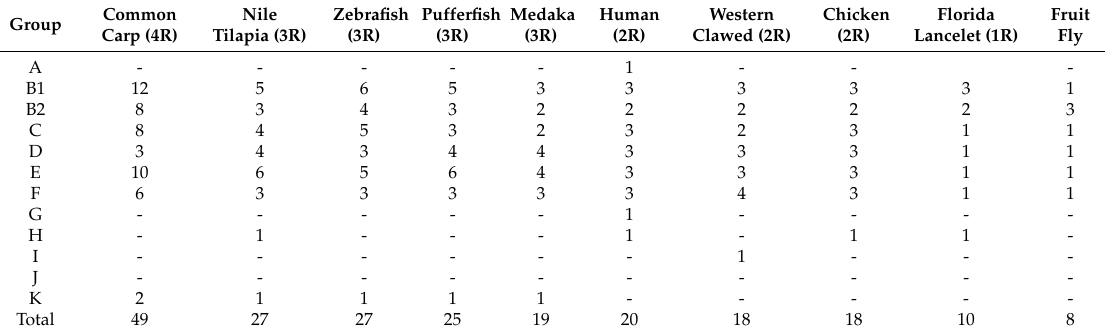
Table 2. Number variation of Sox genes in the Nile tilapia and the other surveyed animals.